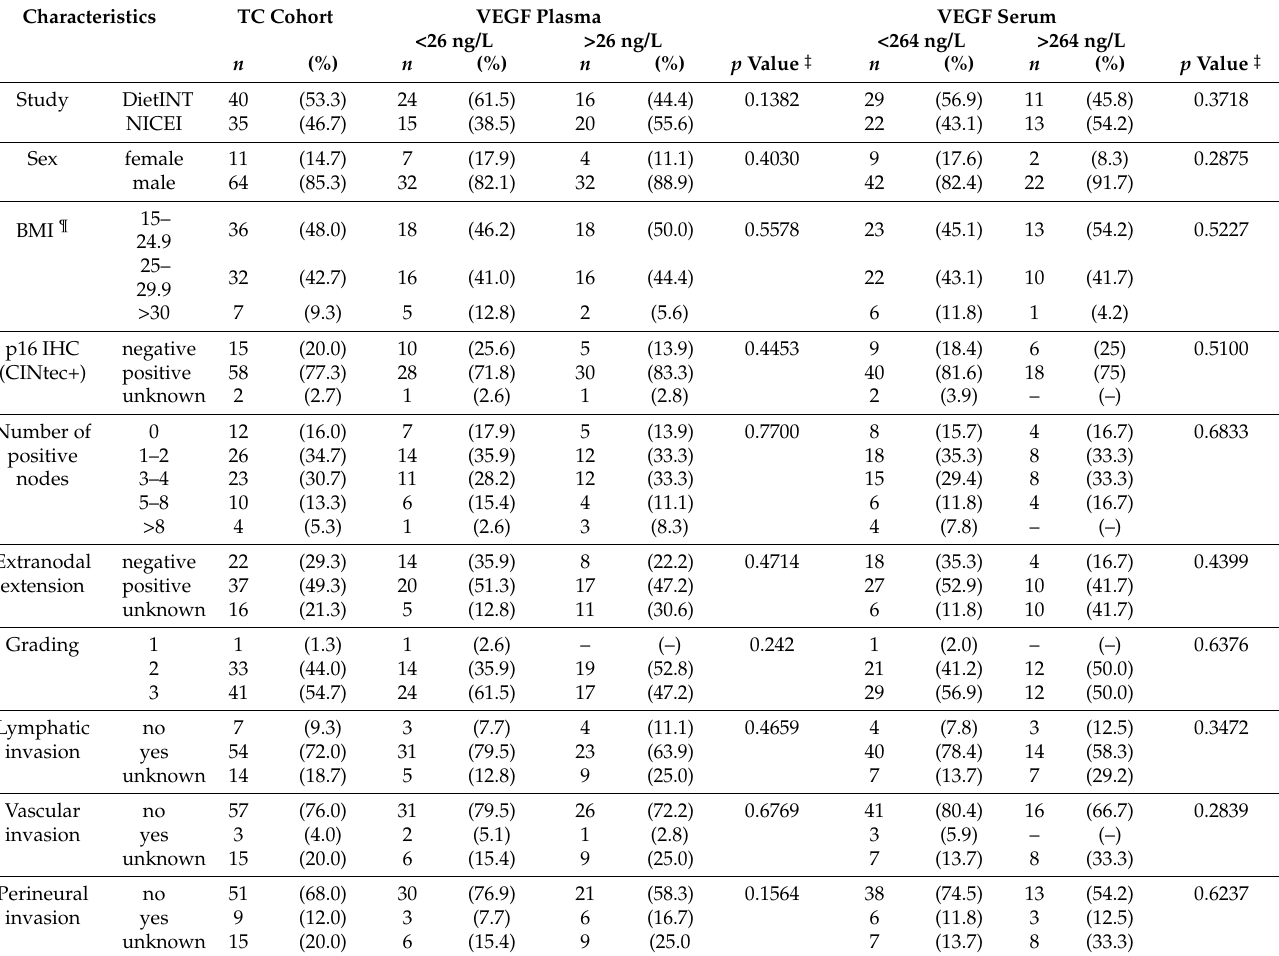
Figure 1. CONSORT diagram illustrating the selection process of n = 179 HNSCC patients under study. Table 1. Characteristics of HNSCC patients of NICEI-CIH and the Leipzig subsample of TRANSCAN-DietINT constituting the test cohort binary classified based on VEGF in plasma (<26 vs. >26 ng/L) or serum (<264 vs. >264 ng/L). Significant differences between groups ( p < 0.05) in Pearson’s Chi-square tests are highlighted